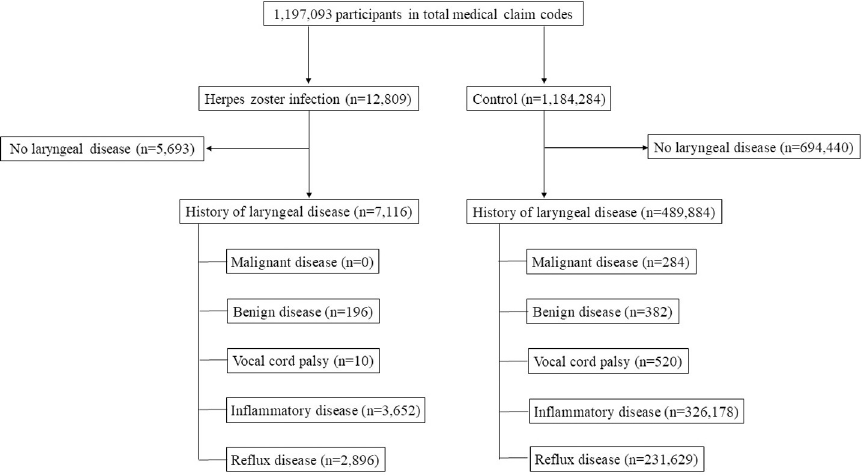
Fig 1. A schematic illustration of the participant selection process used for the present